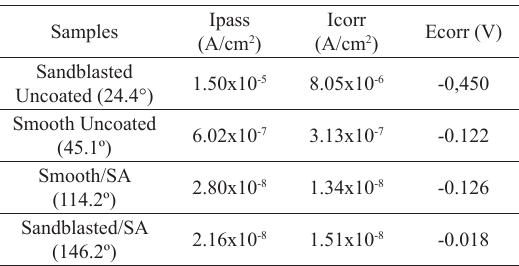
Table 1. Samples with water contact angle, passive current density (Ipass) corrosion current density (Icorr) and corrosion potential (Ecorr) data from the Tafel